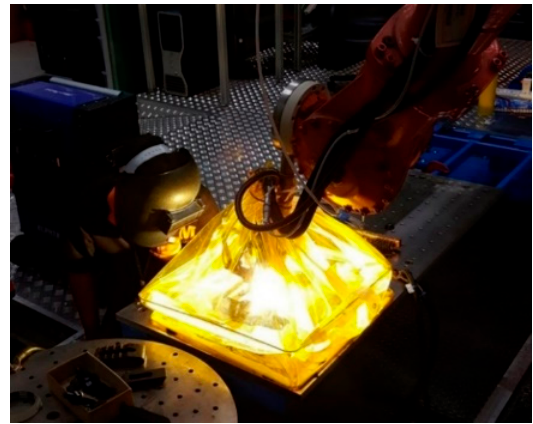
Figure 3. The flow-purge welding chamber.